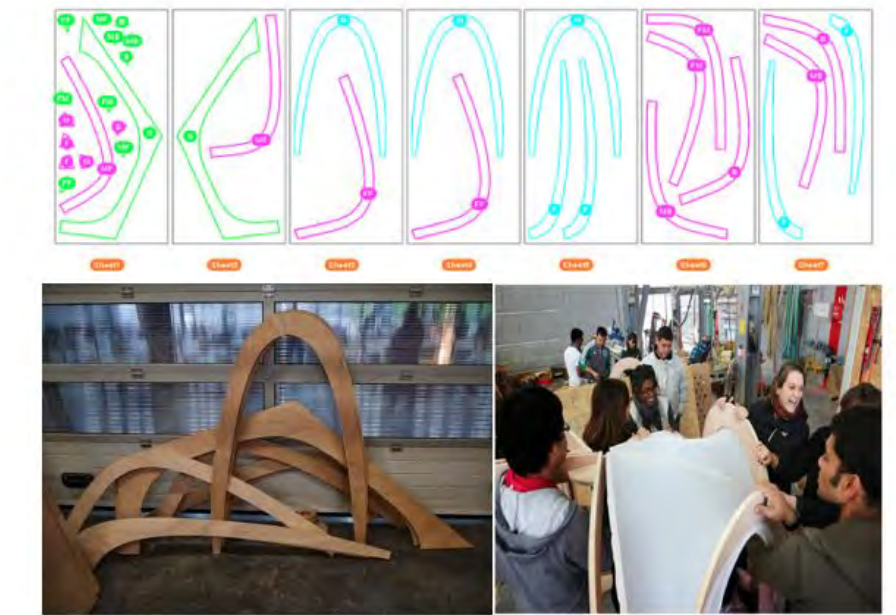
Figure 2. (a) Nesting of cutting filefor the plywood arches to be cut by CNC machine. (b) Use of CNC to cut theplywood arches forming the temporary formwork (left). (c)Placement of the elastic fabric over the wooden arches fixed by staples (right).